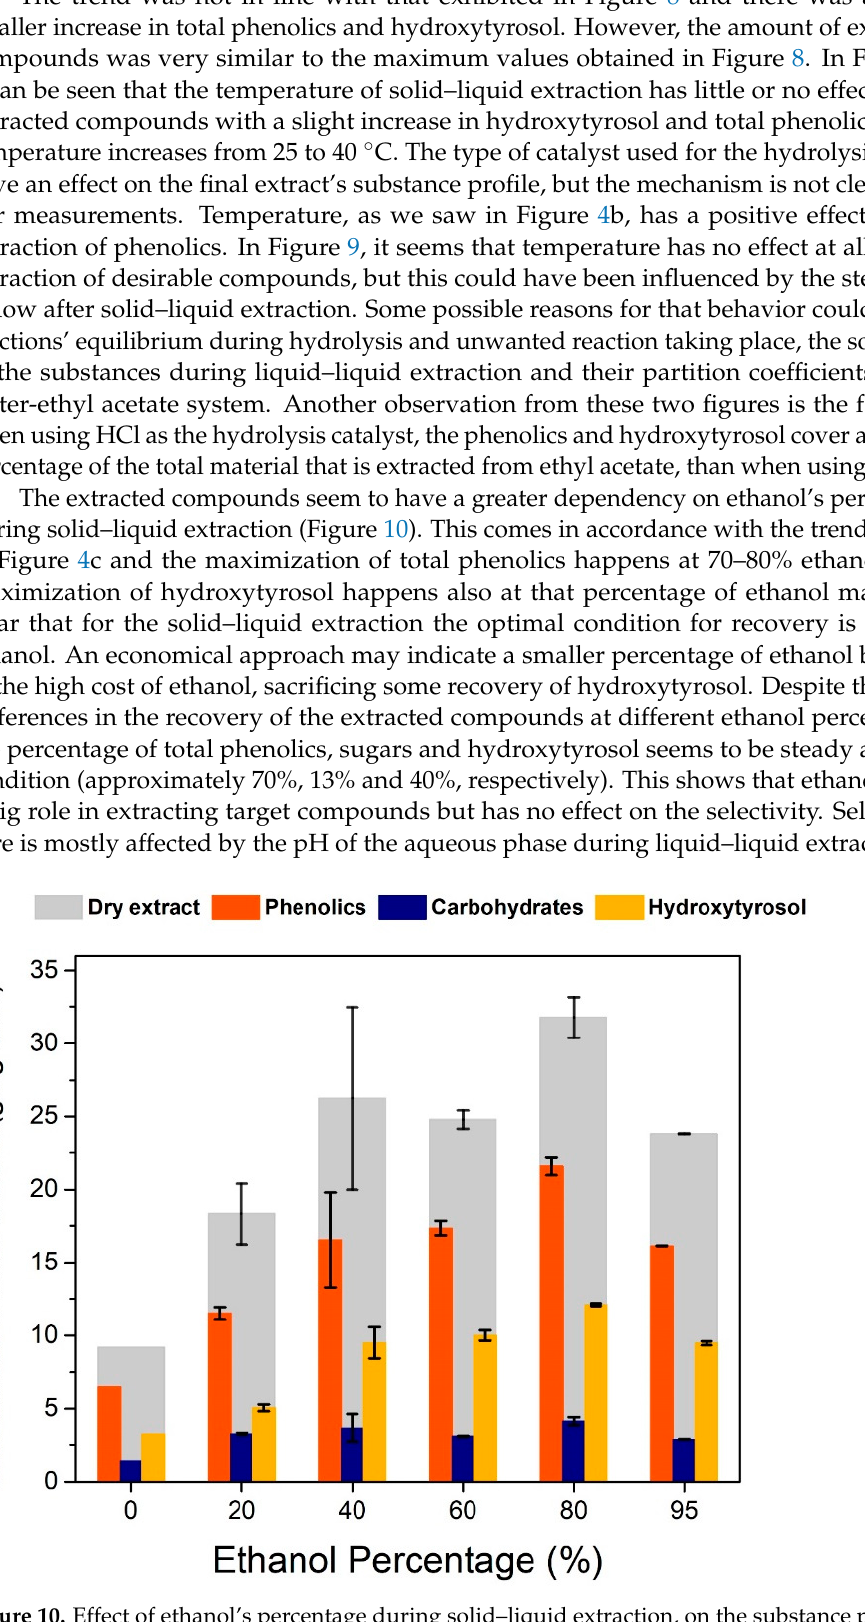
Figure 10. Effect of ethanol’s percentage during solid–liquid extraction, on the substance profile in the final extract. Solid–liquid extraction was performed at 40 °C, hydrolysis was performed with H 2 SO 4 at pH 1.